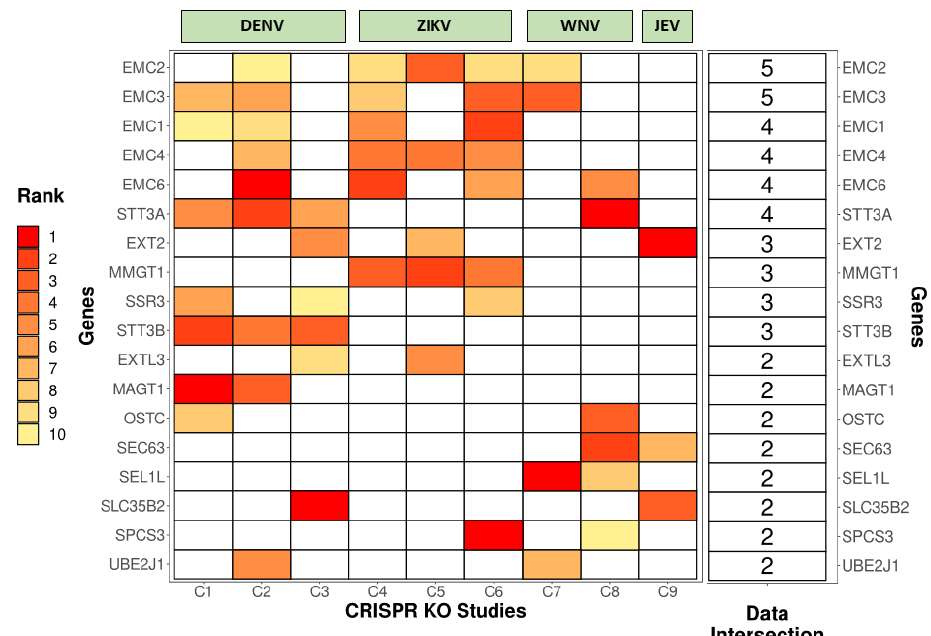
Figure 2. Intersections among different CRISPR KO studies for Dengue Virus (DENV), Zika Virus (ZIKV), West Nile Virus (WNV), and Japanese Encephalitis Virus (JEV). The heat map shows the overlapping genes among the top 10 hits from 9 different CRISPR studies (C1 to C9) and their ranks based on the phenotypic significance (with 1 (Red) being the best to 10 (Yellow) being the last). Boxes colored in white denote that the gene is not present in the filtered dataset. The last column represents the number of studies in which the gene is present. Studies used in the analysis: C1 [53], C2 [54], C3 [55], C4 [56], C5 [57], C6 [58], C7 [59], C8 [60], C9 [61] .